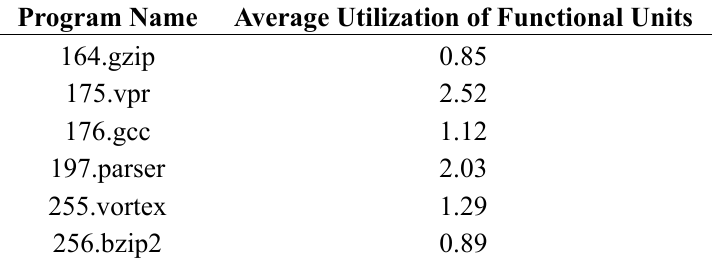
Table 2. Functional units utilization.